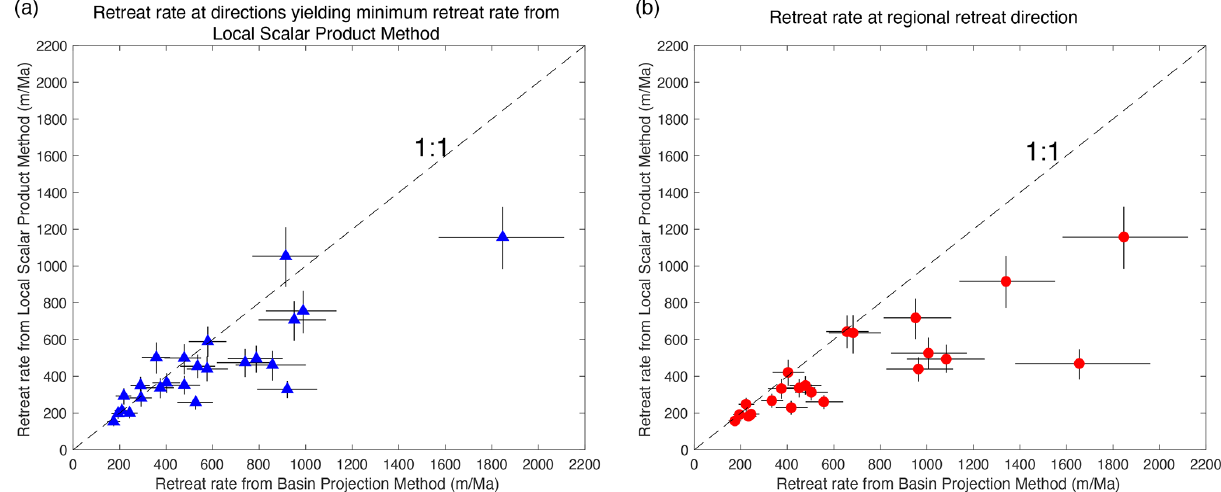
Figure 10. Comparison of retreat rates from the basin projection method and the local scalar product method applied to the data from the Western Ghats escarpment of India. (a) Retreat rates for retreat directions that yield minimum retreat rate from the local scalar product method. Note that direction varies between basins. (b) Rates determined using a constant retreat direction for all basins